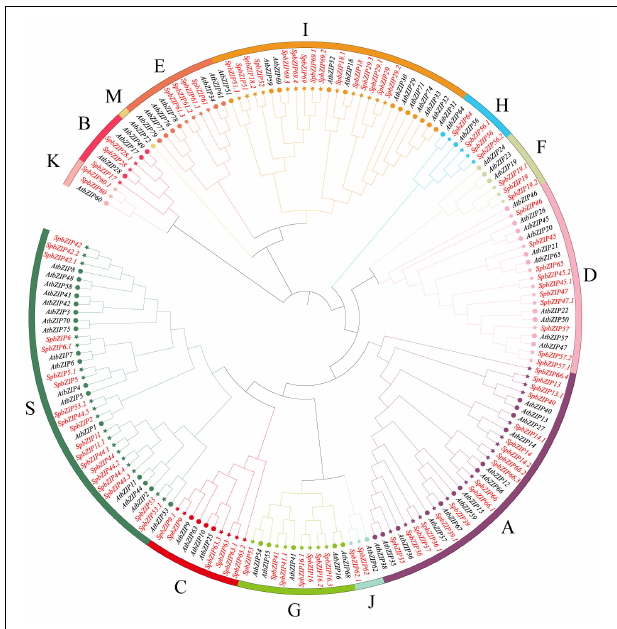
FIGURE 1 | Phylogenetic relationships among the bZIP genes from Sedum plumbizincicola and Arabidopsis . The phylogenetic tree was constructed on the basis of the alignment of S. plumbizincicola and Arabidopsis bZIP proteins according to the maximum-likelihood method, with 1,000 bootstrap replicates.